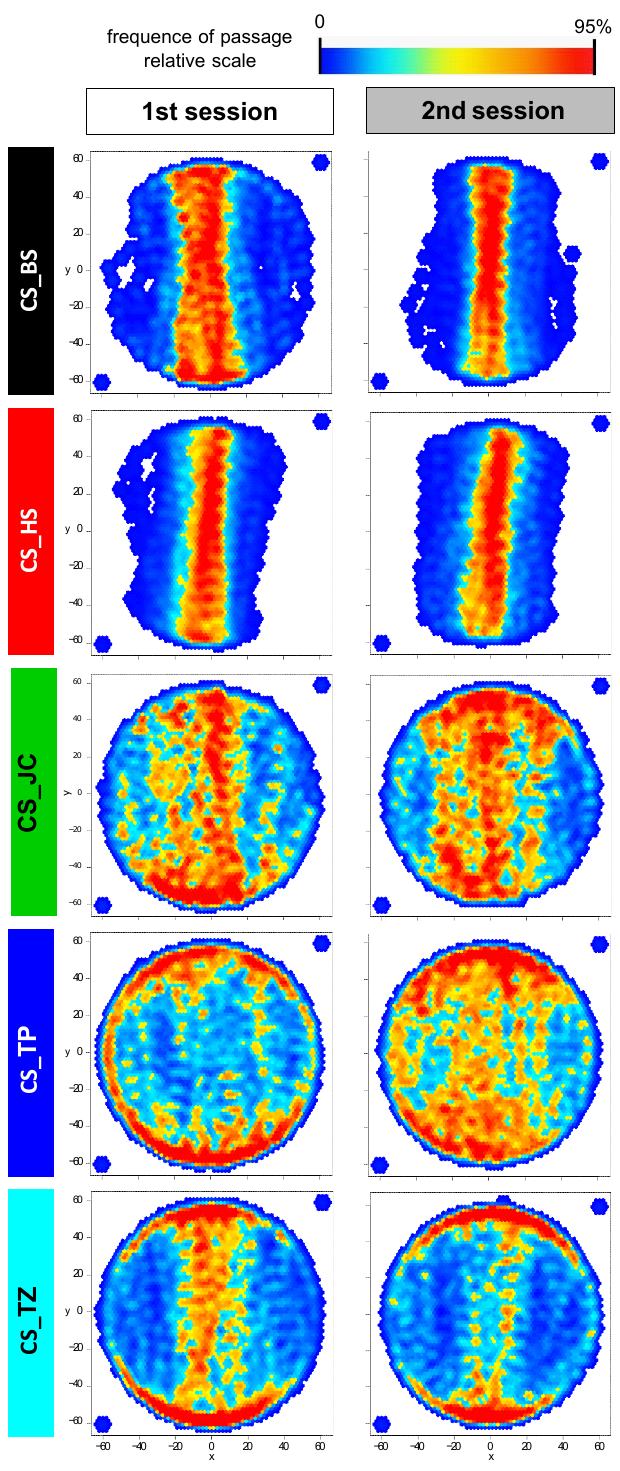
Figure 1. In transition plots, the behavior of each sub-strain looks different from the other strains and similar between the two experimental sessions. Transition plots represent the position of the fly on the platform, excluding the time when the fly was immobile. The scale is proportional, with red points meaning that the number of times the fly was in that position is at least 95% of the maximal score obtained for any position. A Gaussian smooth was applied to the resulting heat map. The two points outside the platform were added manually to assure orthogonal axes of the representation. Sample size is 11–12 for each